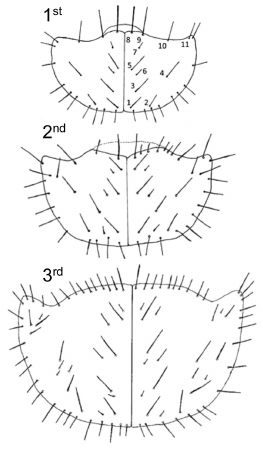
Figure 6. Generalized images of pronotal discs of C. marginipennis , derived from larvae observed in this study, showing setal numbers and arrangement. Top, first instar; middle, second instar; bottom, third instar; all shown in relative size—not to